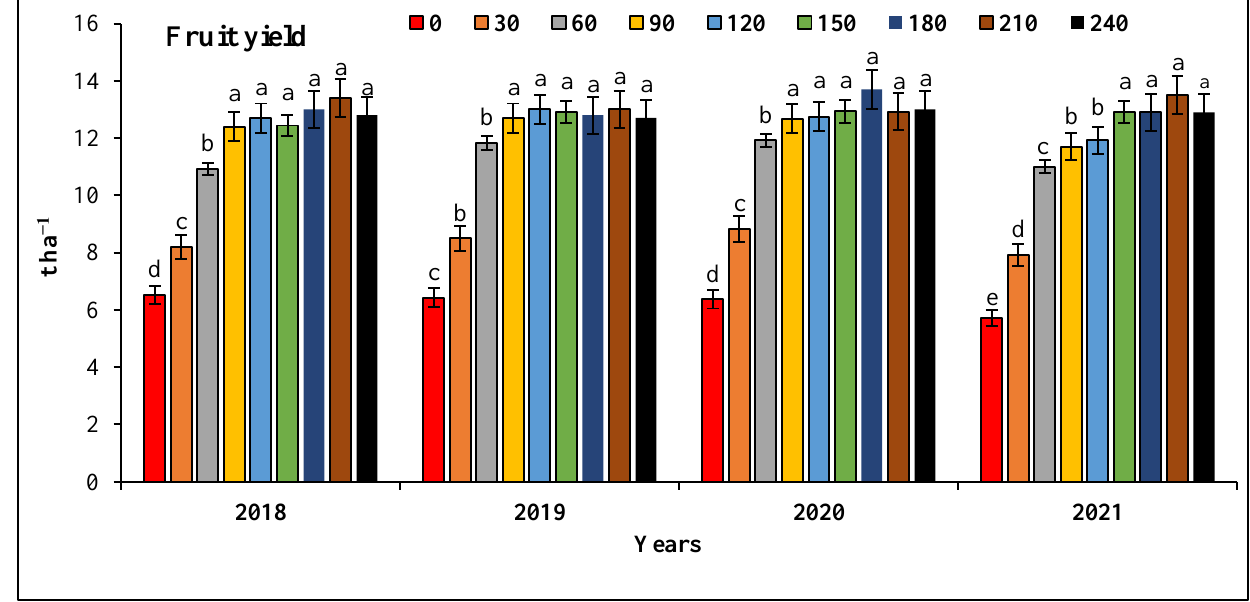
Figure 3. The effect of P doses on mango fruit yield. Means (±SE, n = 4) denoted by different letters indicate significant difference according to Duncan’s test at p < 0.05.